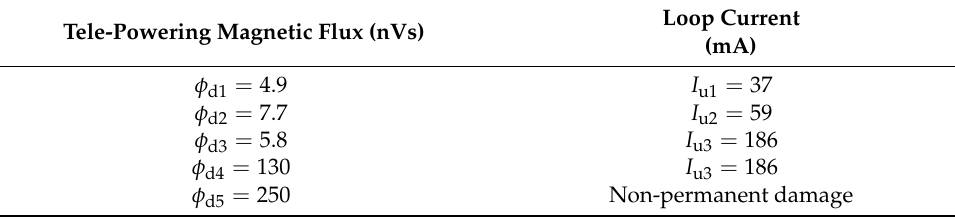
Table 1. Characteristics for a reduced size balise.